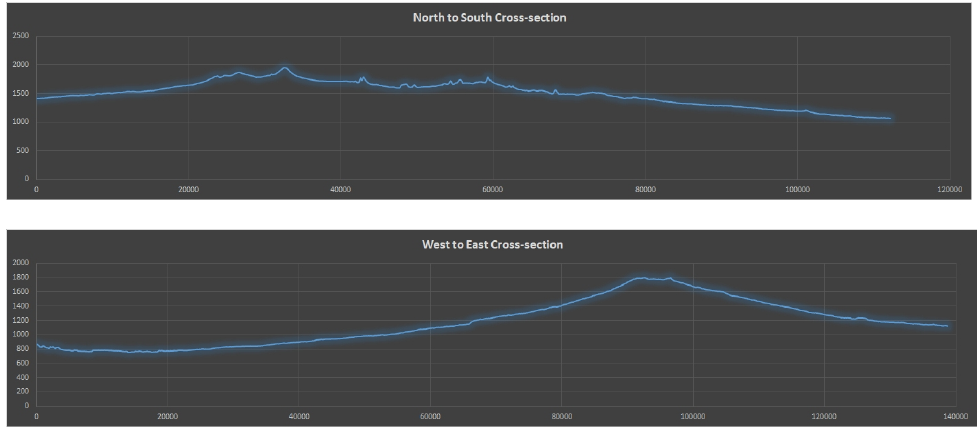
Figure 3. Topographic cross-sections generated in QGIS along the two N–S and W–E transects shown on Figure 2. Note the gentle sloping terrain and the near-steady-elevation dorsal range of vents.